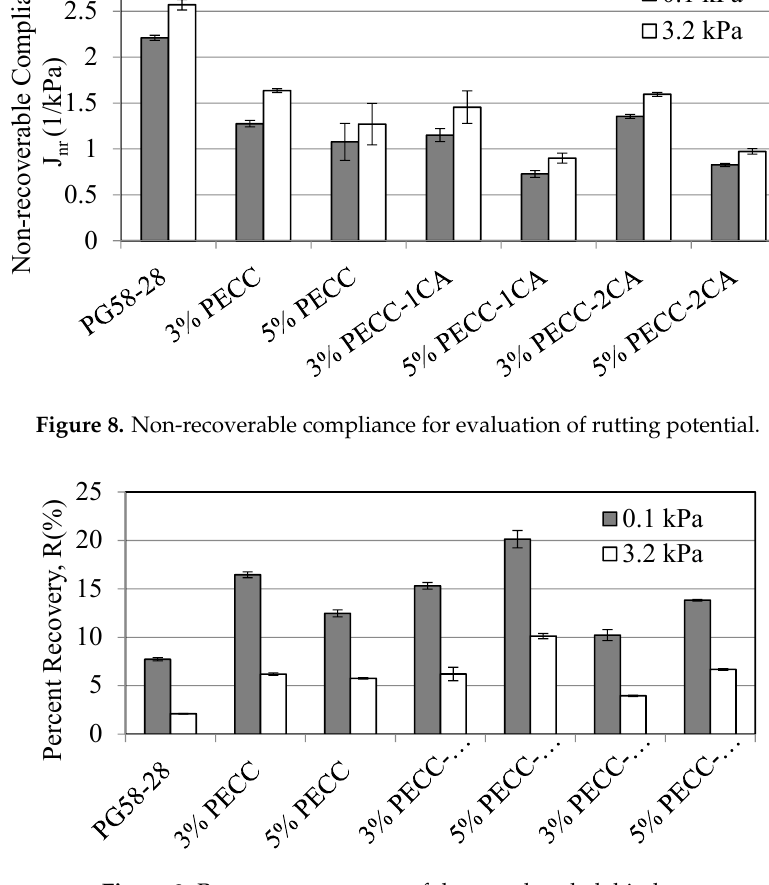
Figure 9. Recovery percentage of the tested asphalt binders.